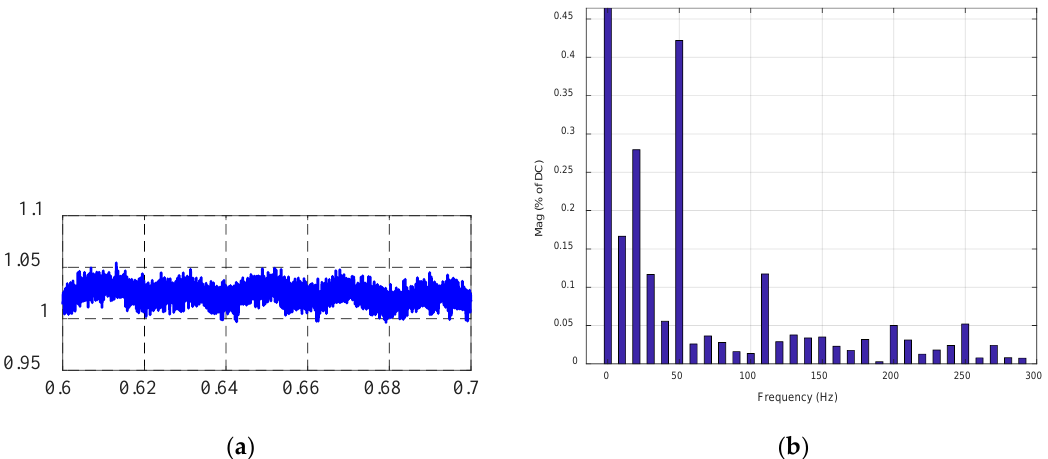
Figure A2. Additional simulation waveforms. ( a ) Zoomed version of dc-link current displayed in Figure 9a, ( b ) FFT spectrum.